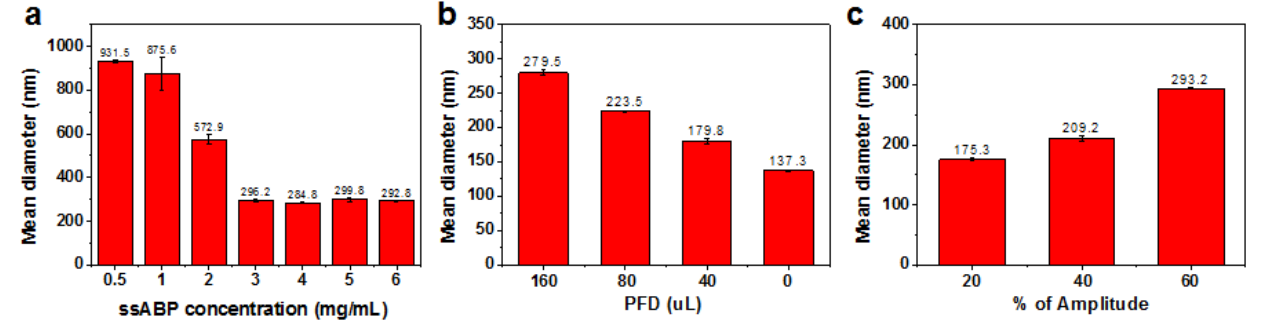
Figure 3. Exploration of formulation and processing parameters that influence the emulsification and fabrication of PFD-nanodroplets. Mean diameter by intensity over ssABP amount ( a ), PFD amount ( b ), and amplitude for ultra-sonication ( c ).